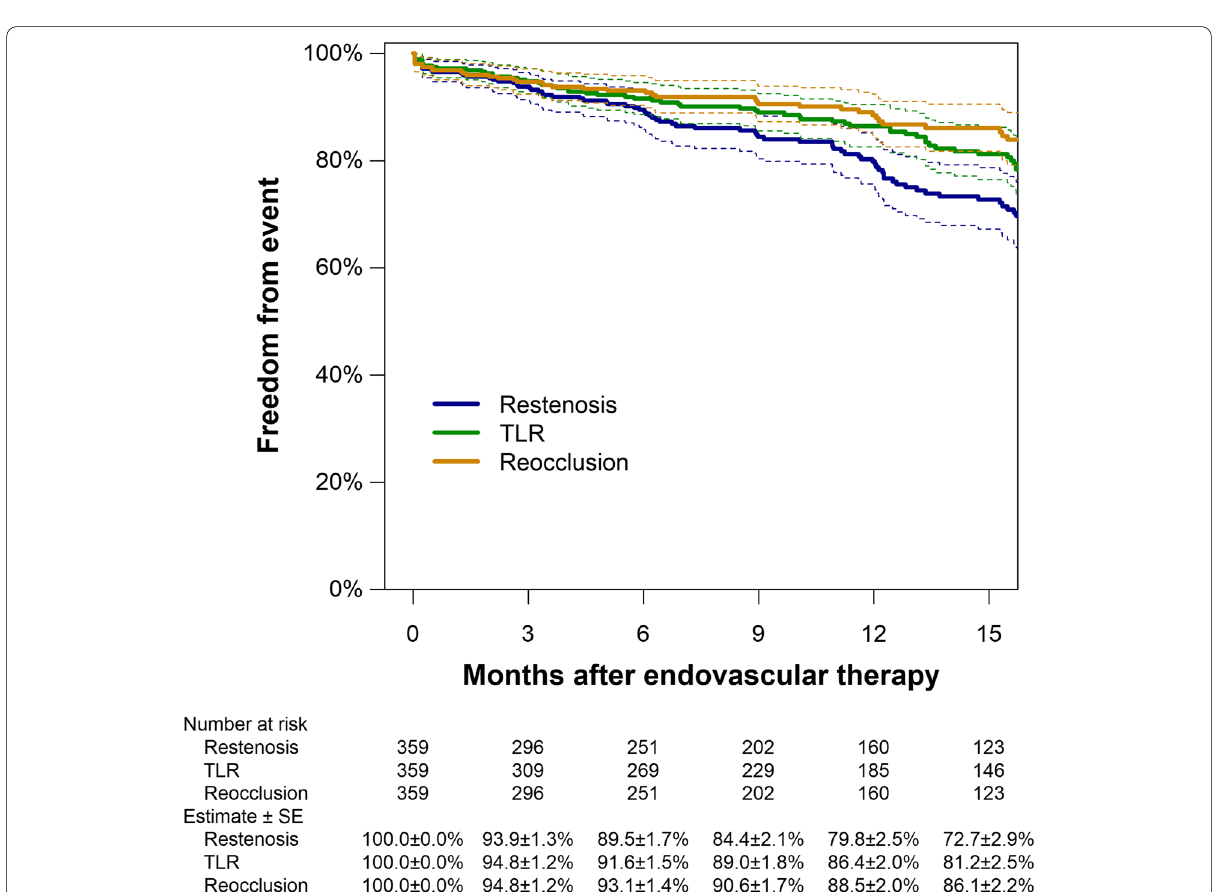
Fig. 1 Kaplan Meier estimates of primary patency, freedom from TLR, and freedom from re-occlusion. Dotted lines indicate 95% confidence intervals. SE, standard